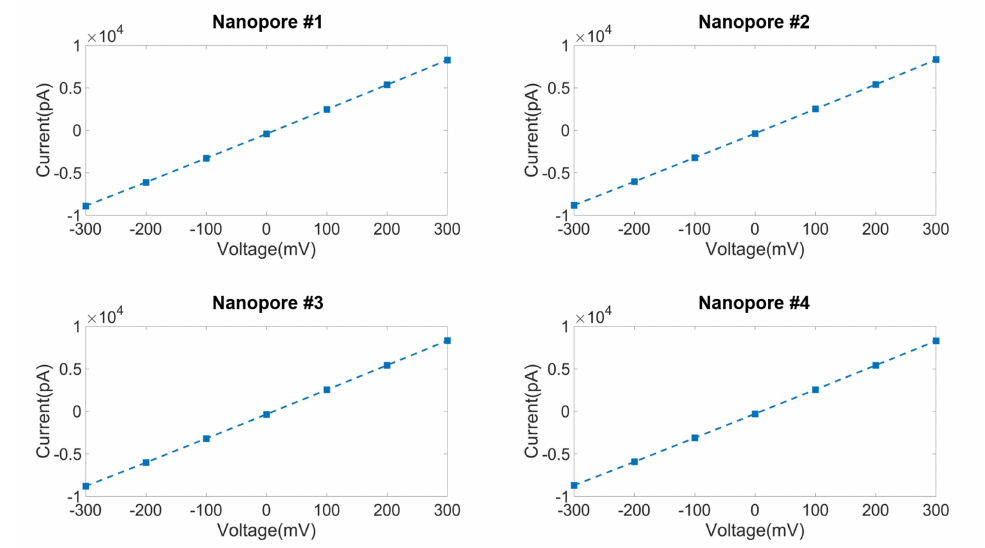
Figure 5. Current-voltage characteristic (IV) curves of four nanopore sensors fabricated by the CDB system designed in this study (Nanopore 1, 2, 3, and 4 have 28.65, 28.53, 28.55, and 28.39 nS,